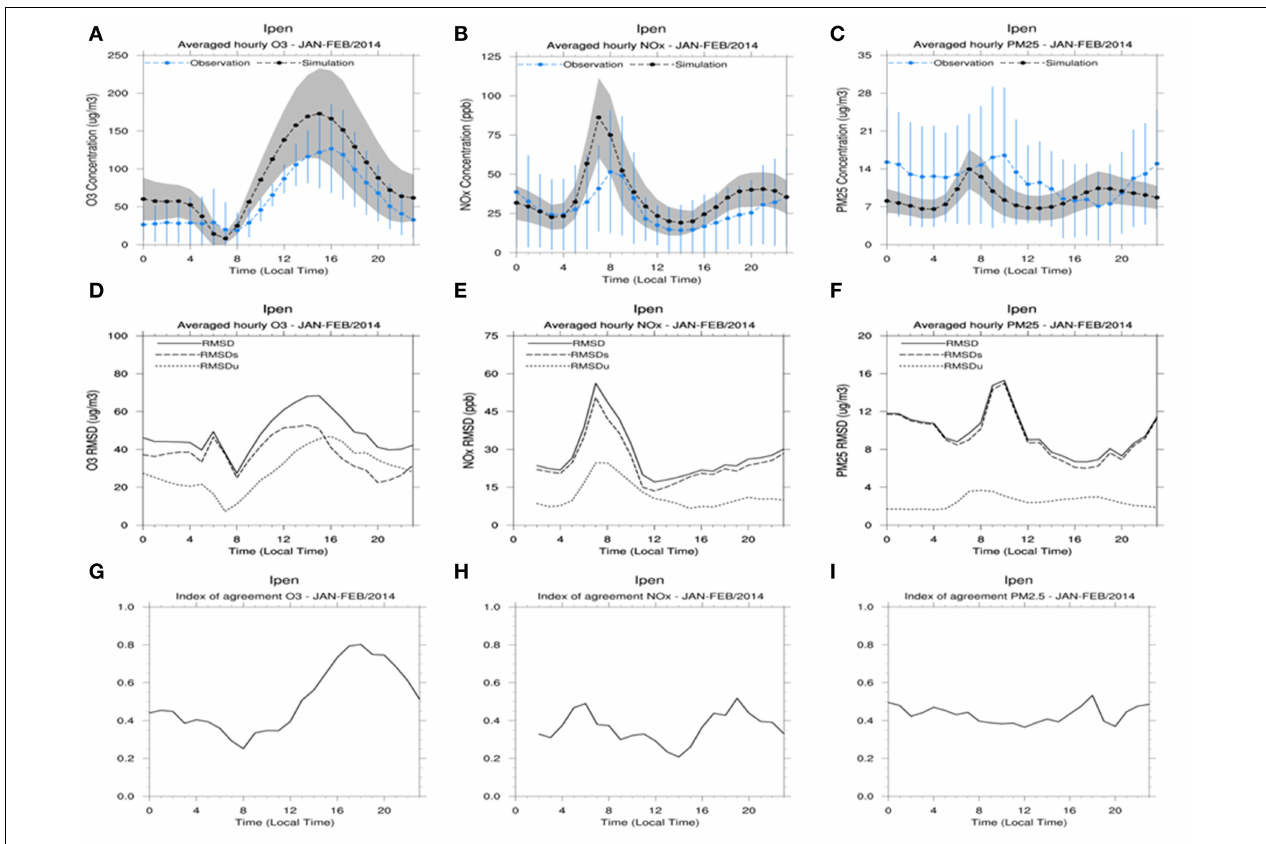
FIGURE 10 | Comparison between modeled and simulated values for O 3 , NO x , and PM 2 . 5 during the January–February 2014 period for the air quality monitoring station at the Instituto de Pesquisas Energéticas e Nucleares (IPEN, Institute for Energy Research and Nuclear Science) on the campus of the University of São Paulo.